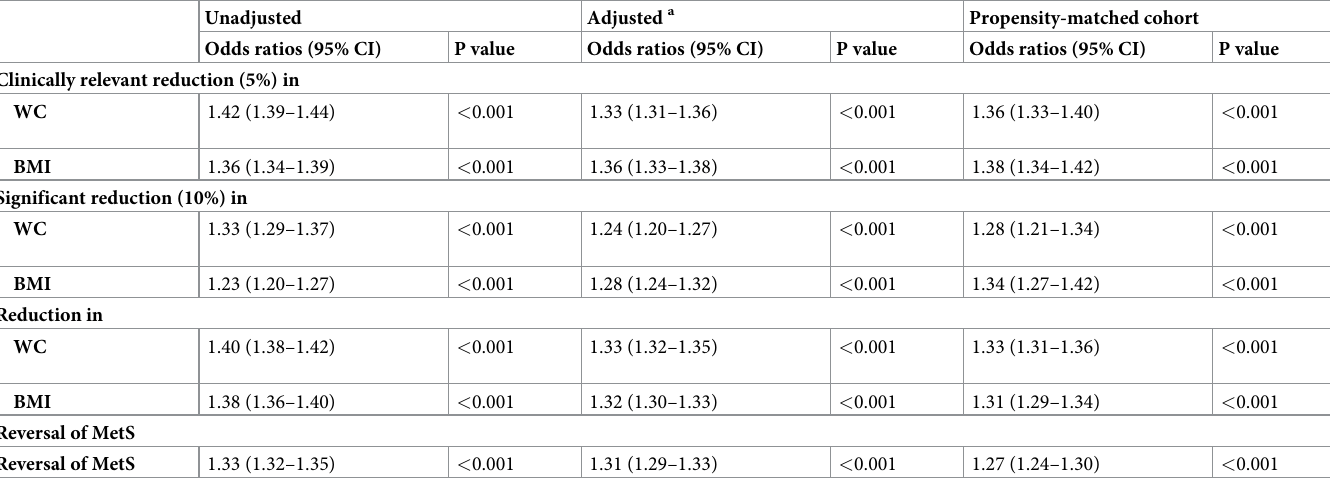
Table 3. Clinical end point in a whole cohort and a propensity-matched